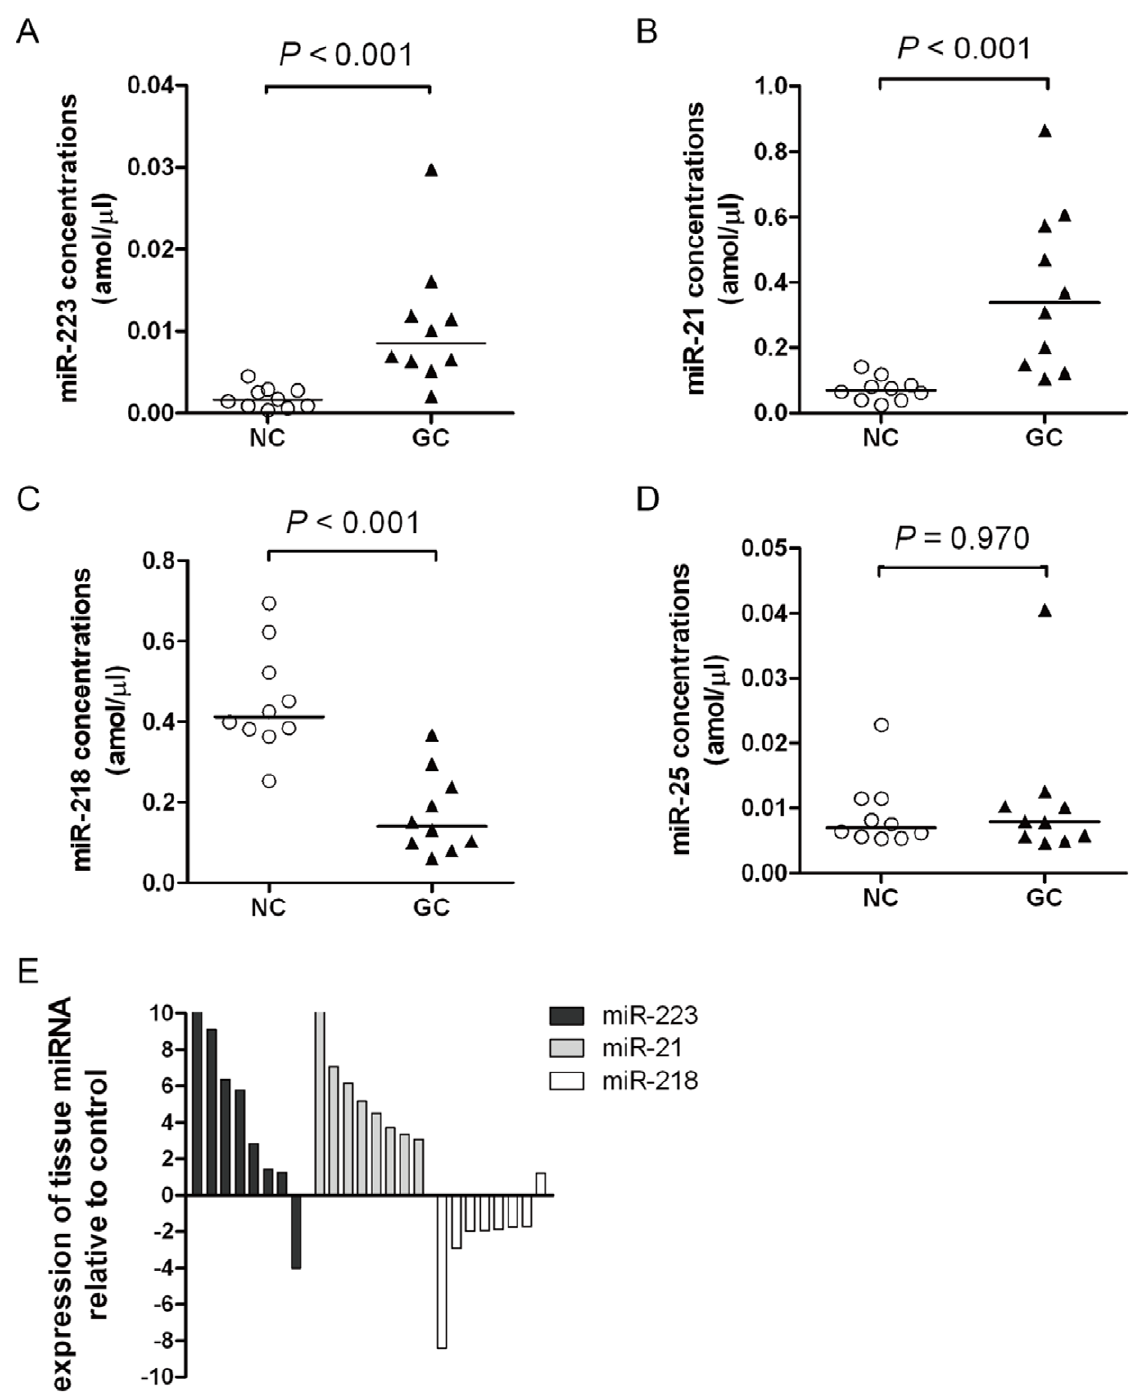
Figure 2. The expression profile signatures of four miRNAs in the initial analysis. Scatter dot plots of the plasma levels of four miRNAs in gastric cancer patients (GC, n=10) and healthy control subjects (NC, n=10). Scatter dot plots show the plasma levels of miR-223 (A ), miR-21 (B) , miR- 218 (C) and miR-25 (D) . The lines in the scatter dot plots denote the medians. ( E ) Bars of the expression levels of miR-223, miR-21 and miR-218 in primary GC tissues and paired normal tissues. The expression levels of miR-223 were higher in primary GC tissues in seven of the eight patients analyzed (87.5%) and miR-21 in eight patients (100%), whereas miR-218 was lower in seven patients (87.5%) than in paired normal tissues. All assays were repeated three times in duplicates. doi:10.1371/journal.pone.0041629.g002 significantly elevated in the GC patients with Hp infection or lower ( P , 0.05). These data provide strong evidences that the three whose without when compared with the healthy controls with Hp miRNA signatures can distinguish GC patients with or without Hp infection or whose without, whereas miR-218 was significantly infection from healthy controls.